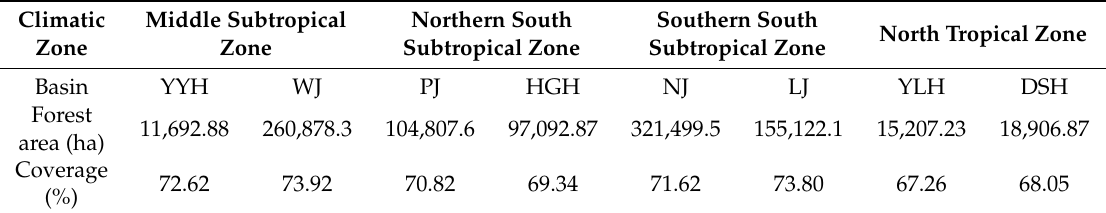
Table 3. Areas and percentages of forests in basin-pairs in the four climatic zones.